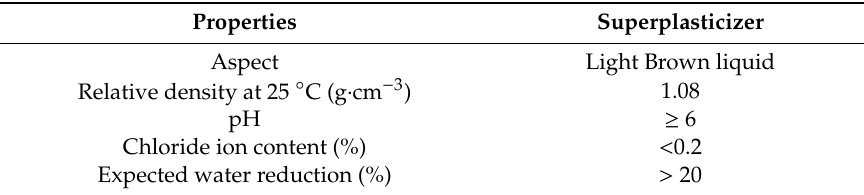
Table 7. Properties of the superplasticizer